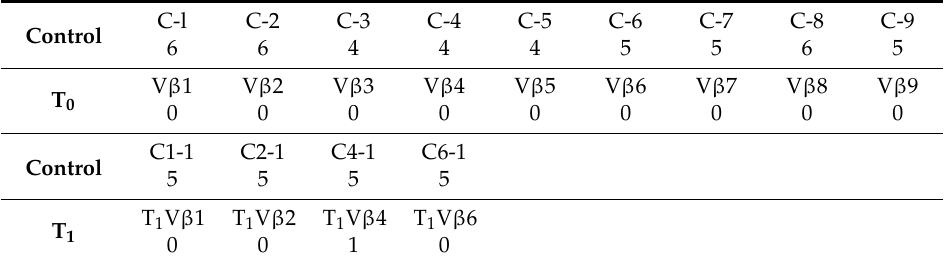
Table 2. Comparison of disease severity scores [1] for CLCuKoV-Bu-CLCuMB-inoculated T 0 (generation 0) and T 1 (generation 1) transformed and non-transformed cotton plants. The rating system is: 0 = no symptoms, 1–5 = incrementally, increasingly severe, and 6 = characteristic, severe leaf curl symptoms caused by Cotton leaf curl Kokhran virus -Burewala/Cotton leaf curl Multan betasatellite (CLuKoV-Bu/CLCuMB) infection of susceptible cultivars.